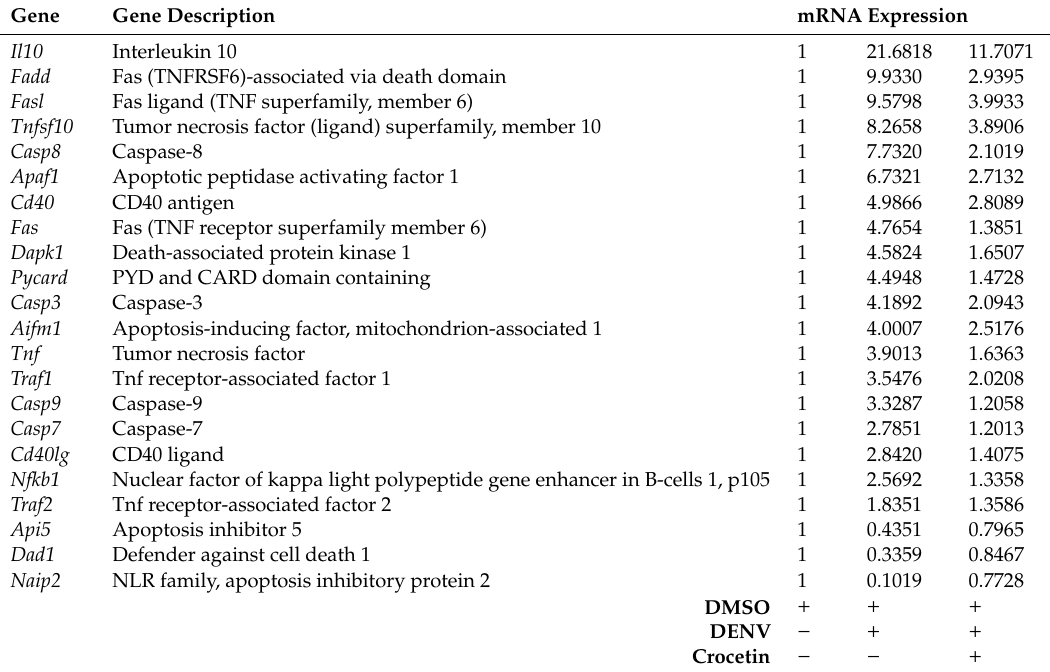
Table 2. Expression profiles of selected genes from the apoptosis PCR array